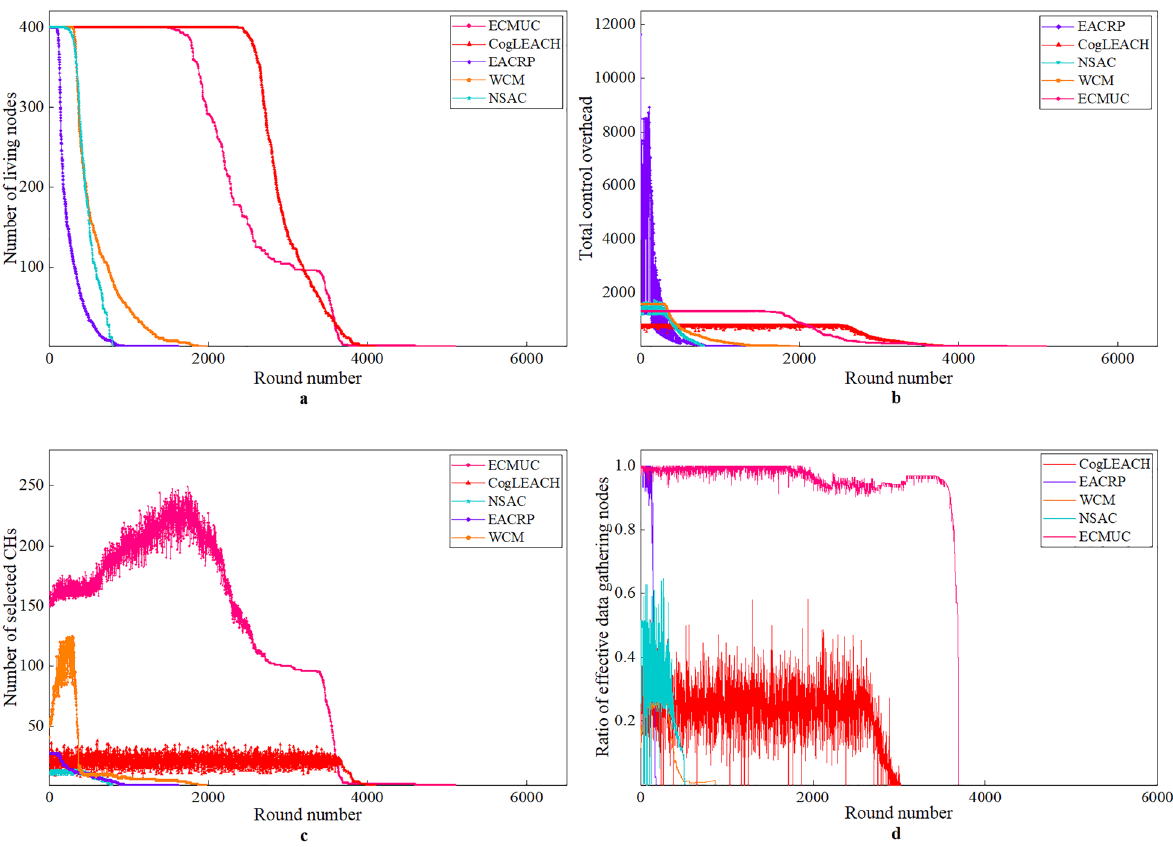
Figure 7. Performance comparison results in Case